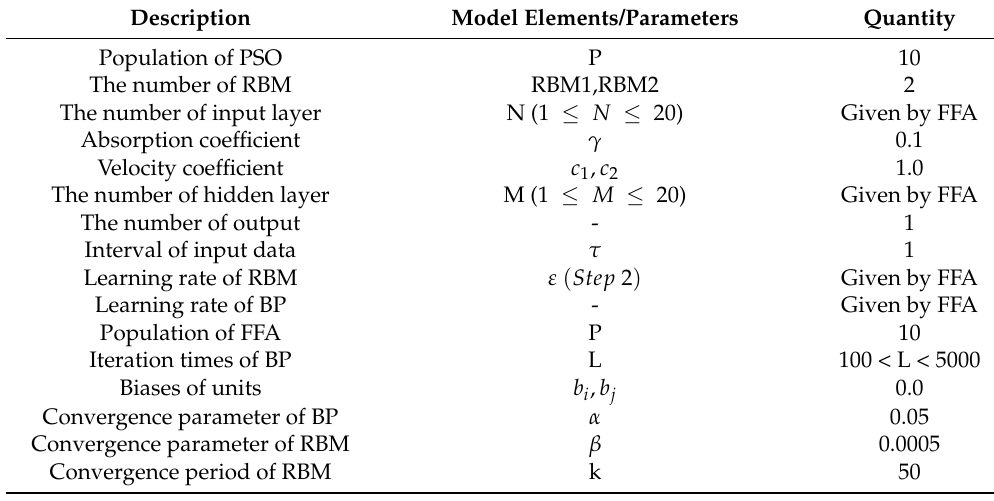
Table 2. The used parameters in the prediction